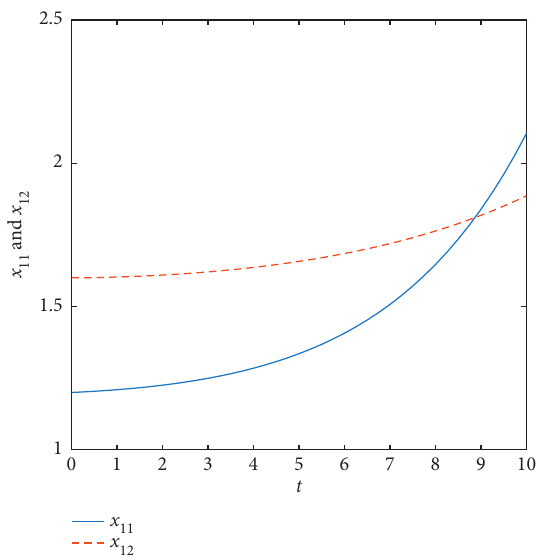
Figure 10: The pollution emission trajectory of the upstream re- gion under cooperation.